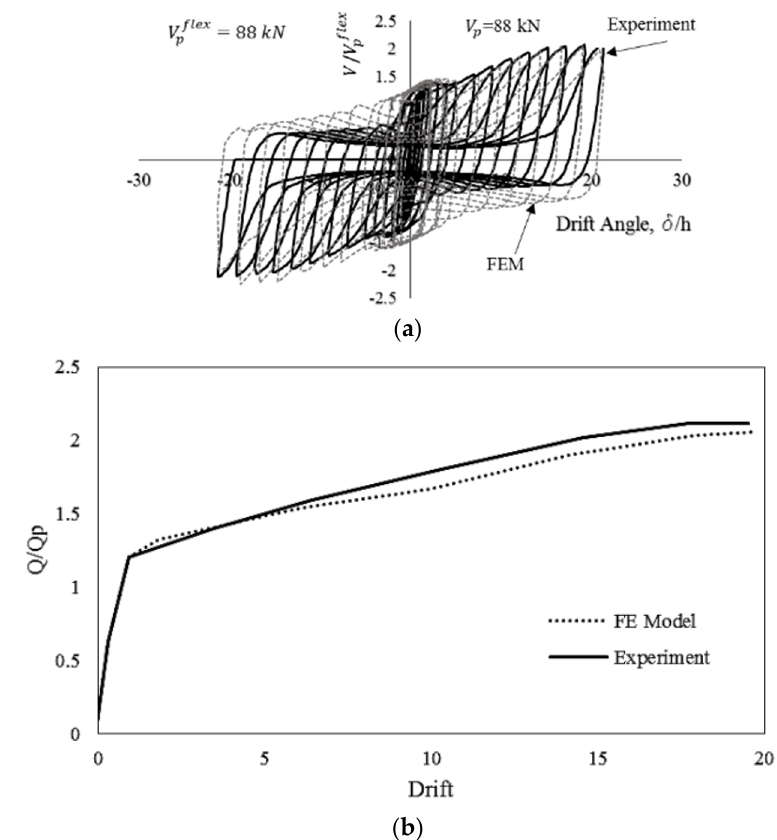
Figure 15. Verification of Finite Element Modeling with the aid of FE software under ( a ) cyclic be- havior and ( b ) monotonic loading conditions.